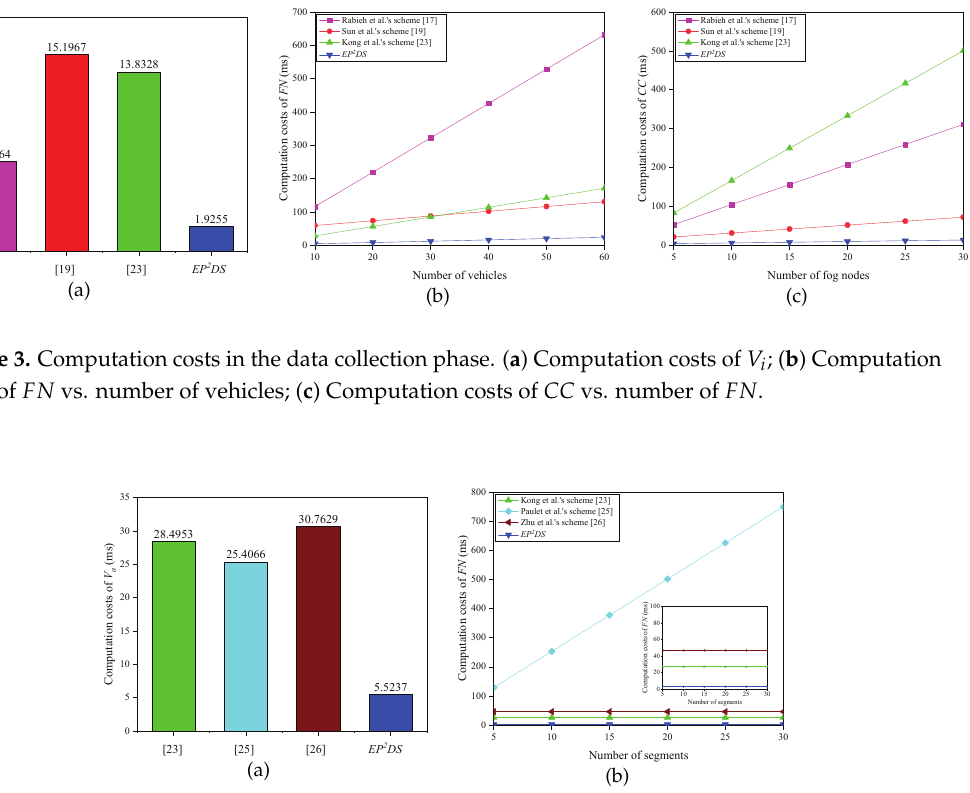
Figure 4. Computation costs in the data query phase. ( a ) Computation costs of V q ; ( b ) Computation costs of FN vs. number of